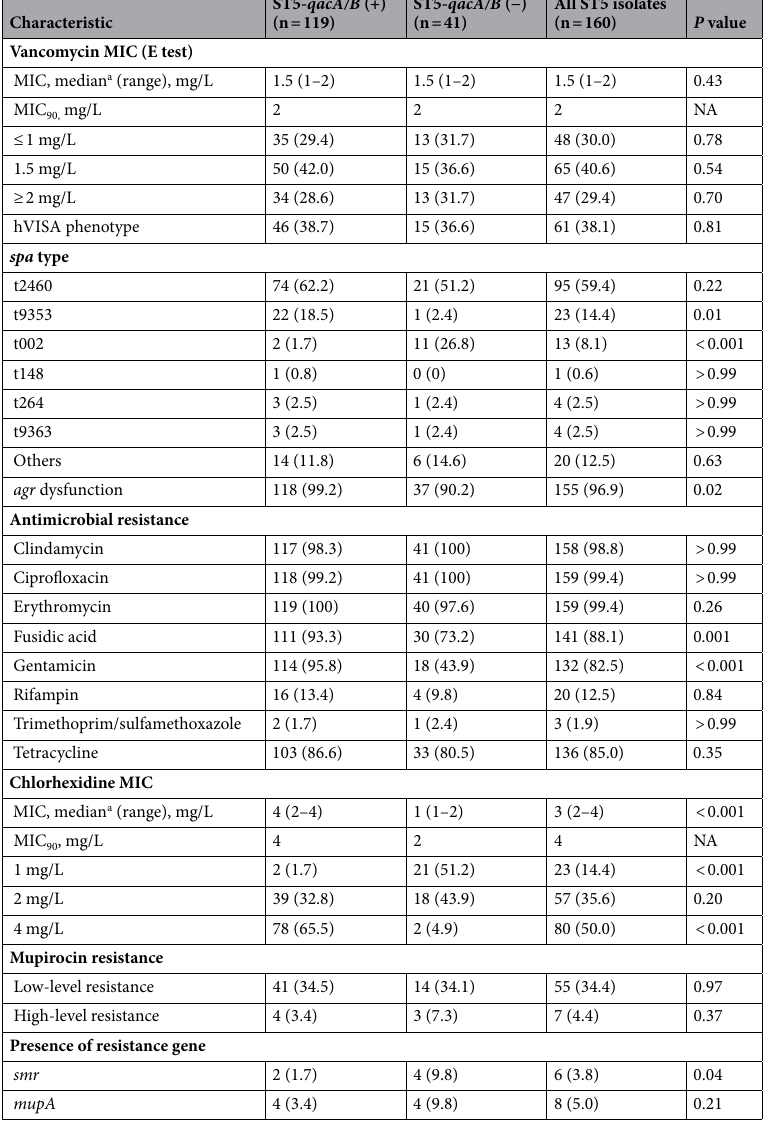
Table 2. Microbiological and genotypic characteristics of ST5-MRSA-II blood isolates according to qacA/B status. Data are no. (%) of patients, unless otherwise indicated. hVISA heterogeneous